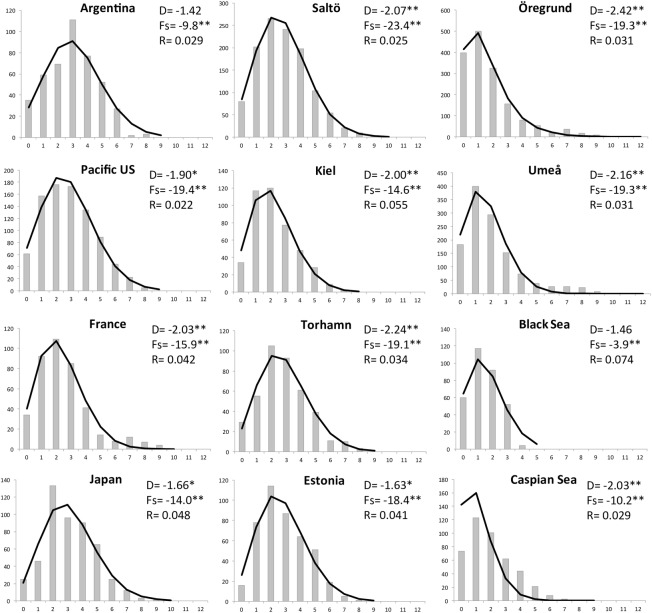
Mismatch distributions based on COI sequences from B. improvisus populations.Observed mismatch distribution (bars) and expected mismatch distributions under the sudden expansion model (solid line) of mtDNA COI sequences for each population. D = Tajima’s D, FS = Fu’s FS, R = raggedness value. Significance is presented as *: P = 0.01–0.05, **: P < 0.01. The populations are sorted according to the pattern of mismatch distribution, with populations displaying more diverged haplotypes (2–4 mismatches) to the left, and populations with less differentiated haplotypes (1–2 mismatches) to the right.